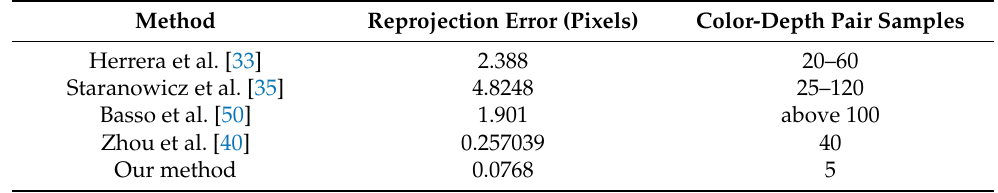
Table 5. Re-Projection error and amount of